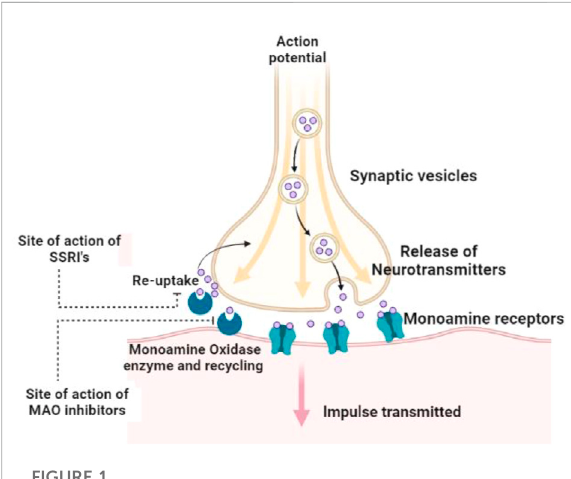
The monoamine (MAO) theory of depression; antidepressant drugs increase monoamine concentrations in the synaptic cleft leading to further signaling and the postsynaptic